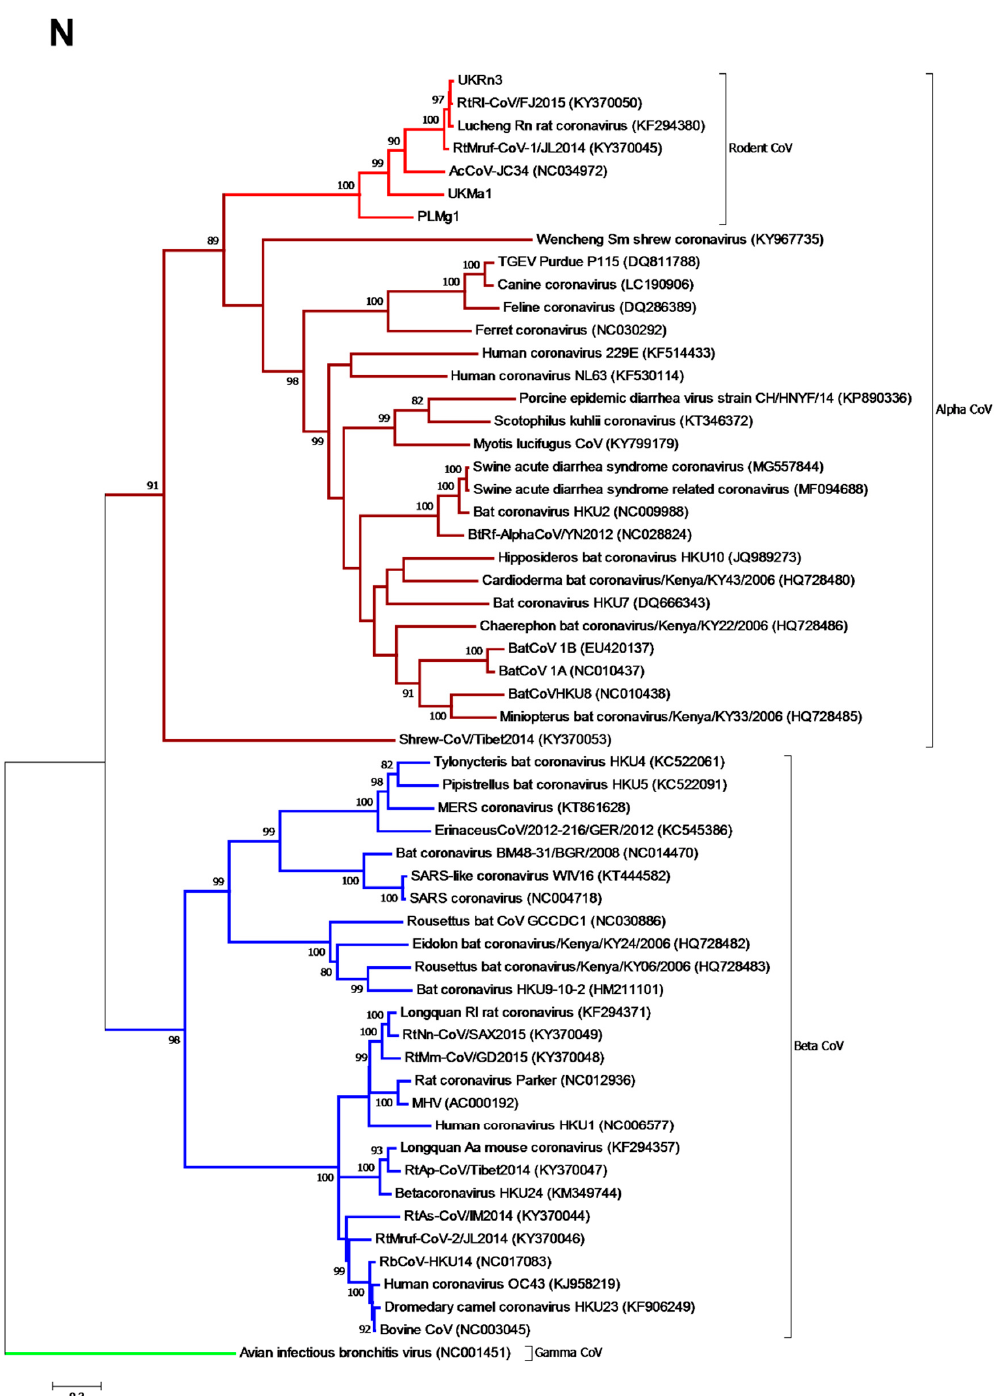
Figure 3. Phylogenetic relationships of the rodent alphacoronaviruses based on the N gene. Maximum likelihood phylogenetic analysis of coronavirus partial N gene sequences corresponding to positions 10–1173 of the Lucheng Rn CoV (KF294380). Novel coronavirus sequences obtained from PL-resident Myodes glareolus (PL Mg 1) and the UK Microtus agrestis (UK Ma 1) and the UK Rattus norvegicus (UK Rn 3) were analysed alongside reference sequences representing three different coronavirus genera ( Alphacoronavirus , Betacoronavirus, and Gammacoronavirus as an outgroup). Reference sequences are indicated by their GenBank accession numbers. Branch lengths are drawn to a scale of nucleotide substitutions per site. Numbers above individual branches indicate the percentage that that branch was found in 1000 bootstrap replicates; only values >80% are shown. Alpha-CoVs are